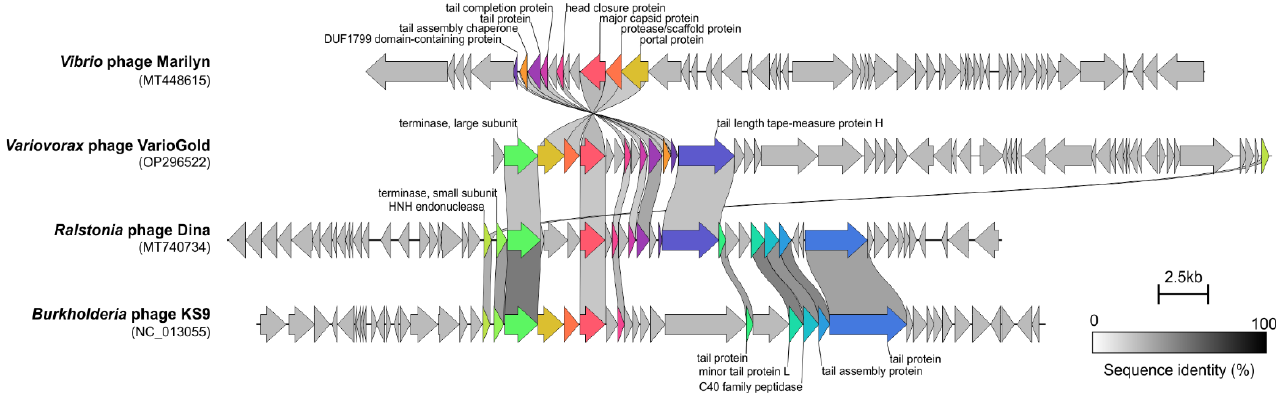
Figure 3. Comparative genome alignment of VarioGold and the three phages. The alignment was created with Clinker using default settings. Each ORF is represented by an arrow. ORF-encoding proteins that did not share sequence similarity are colored gray, while others are connected with blocks reflecting the degree of sequence identity and are color-coded. Sequence identity ranged between 32% and 60%.